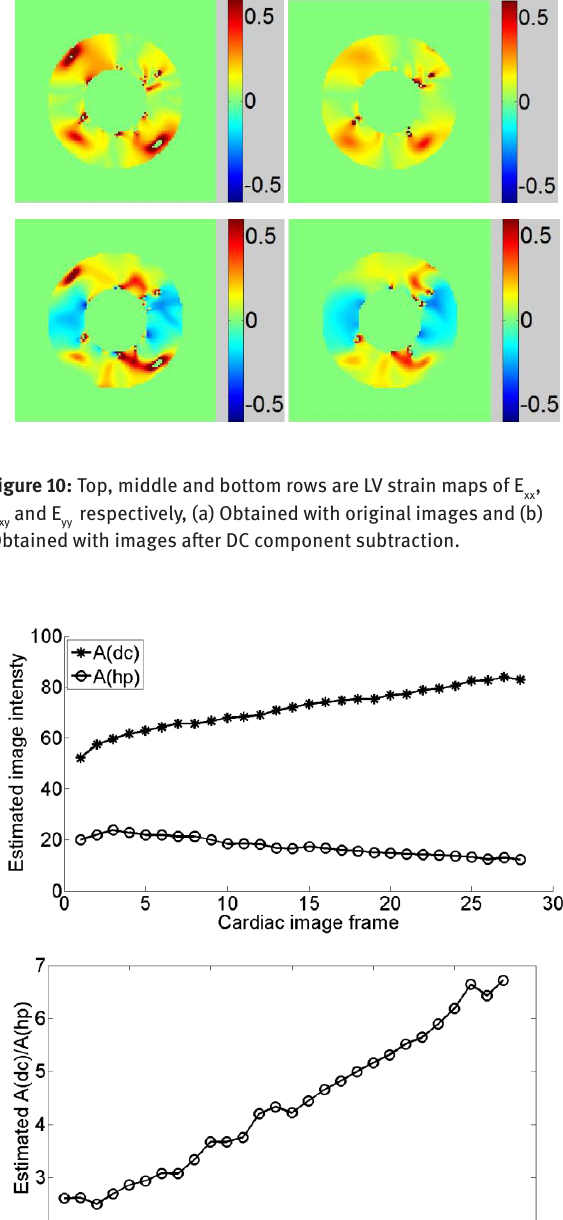
Figure 11: To p: Estimated A A / A dc hp